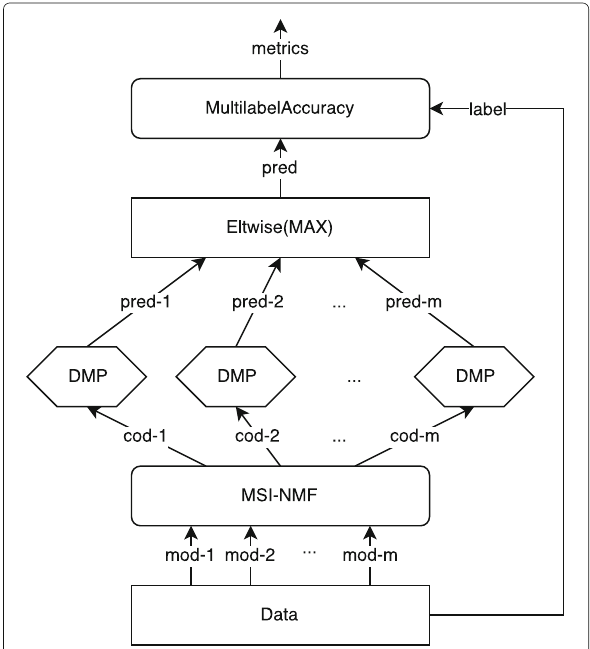
Fig. 2 Test structure of MPENet. Following Caffe terminology, this figure shows the computation graph of test phase. Legends can